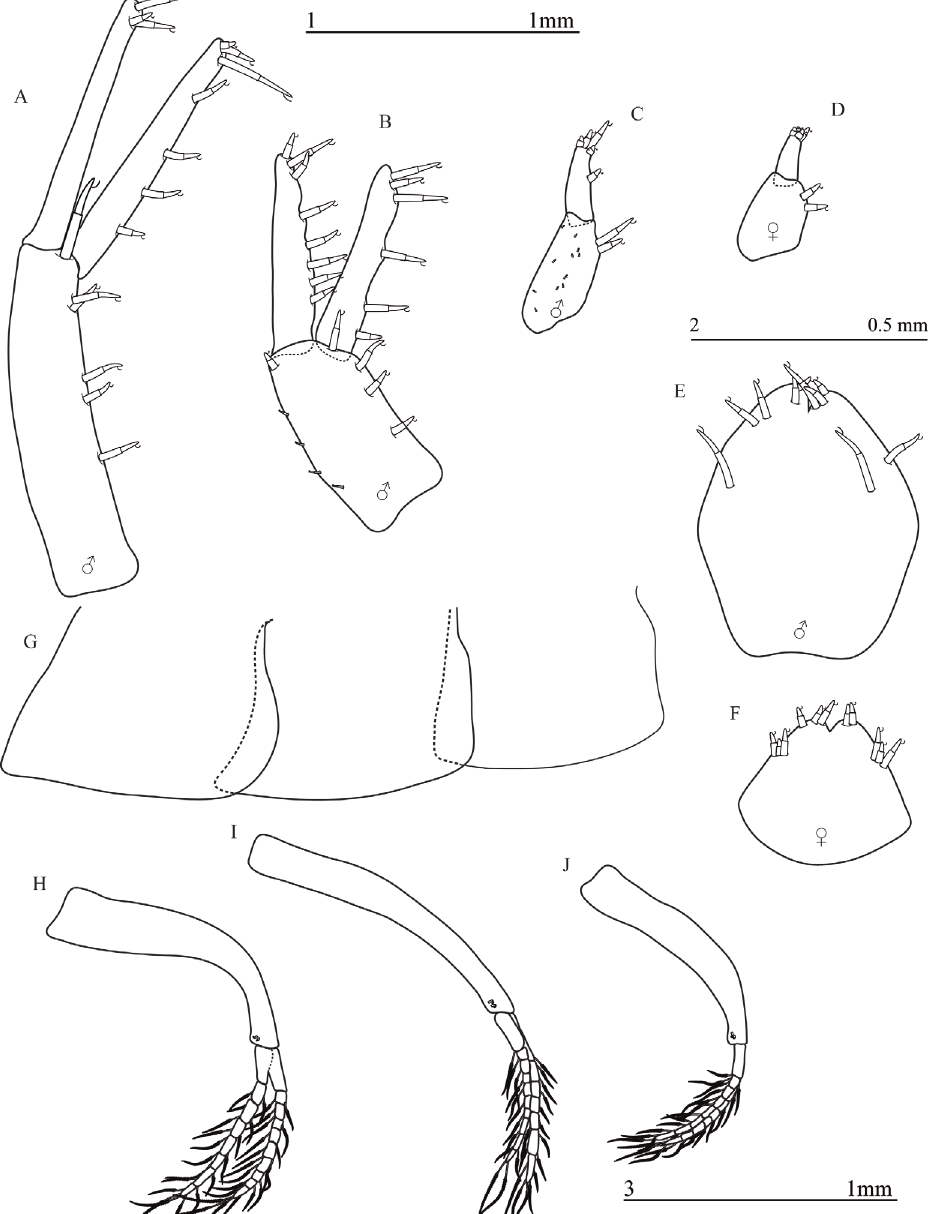
Fig. 5. Cerrorchestia taboukeli sp. nov. A–C, E, G–I . Holotype, ♂, 11.3 mm, MNHN-IU-2019-2276. D, F . Paratype, ♀, 9.6 mm, MNHN-IU-2019-2278. A . Uropod 1 (scale 1). B . Uropod 2 (scale 1). C . Uropod 3 (scale 1). D . Uropod 3 (scale 1). E . Telson lobes (scale 2). F . Telson lobes (scale 2). G . Epimera 1–3 (scale 1). H . Pleopod 1 (scale 3). I . Pleopod 2 (scale 3). J . Pleopod 3 (scale